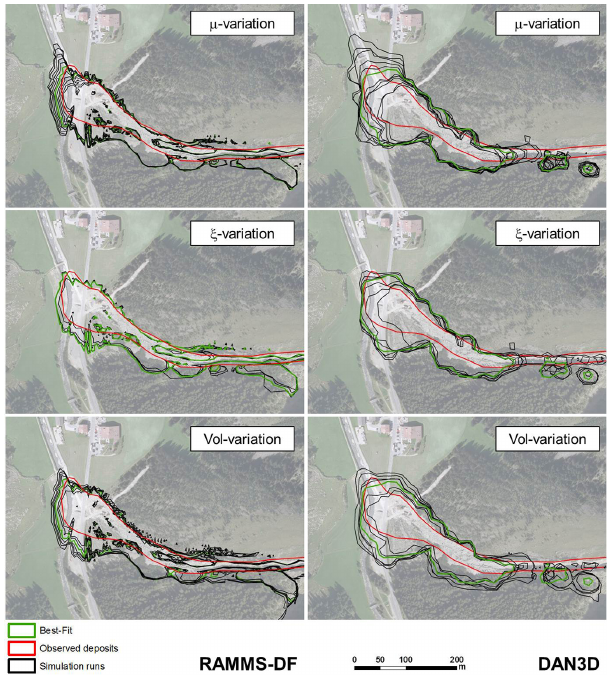
Figure 4. Variation of the Voellmy parameters (0.03–0.16 for µ and 100–700ms − 2 for ξ ) and the initial volume (from 15000 to 50000ms − 2 ) for the RAMMS–DF and the DAN3D codes for the Pitztal study area. When varying one parameter, the others were kept constant. Outlines of the simulation runs are given in black, and the best-fit simulation in green. The observed deposits of the event in 2009 are presented in